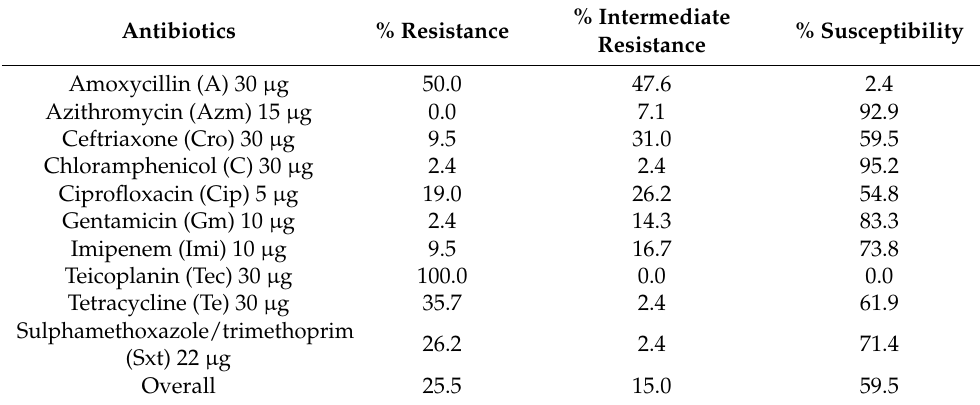
Table 2. Percentage of Antimicrobial Susceptibility of E. coli